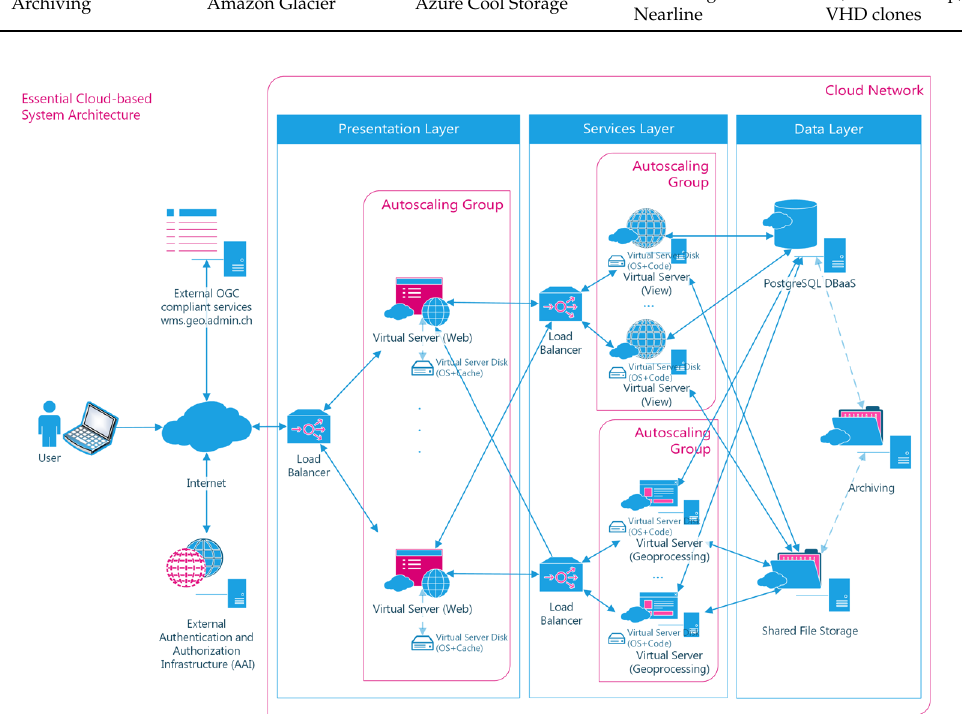
Figure 4. Essential cloud-based system architecture for geoportals.